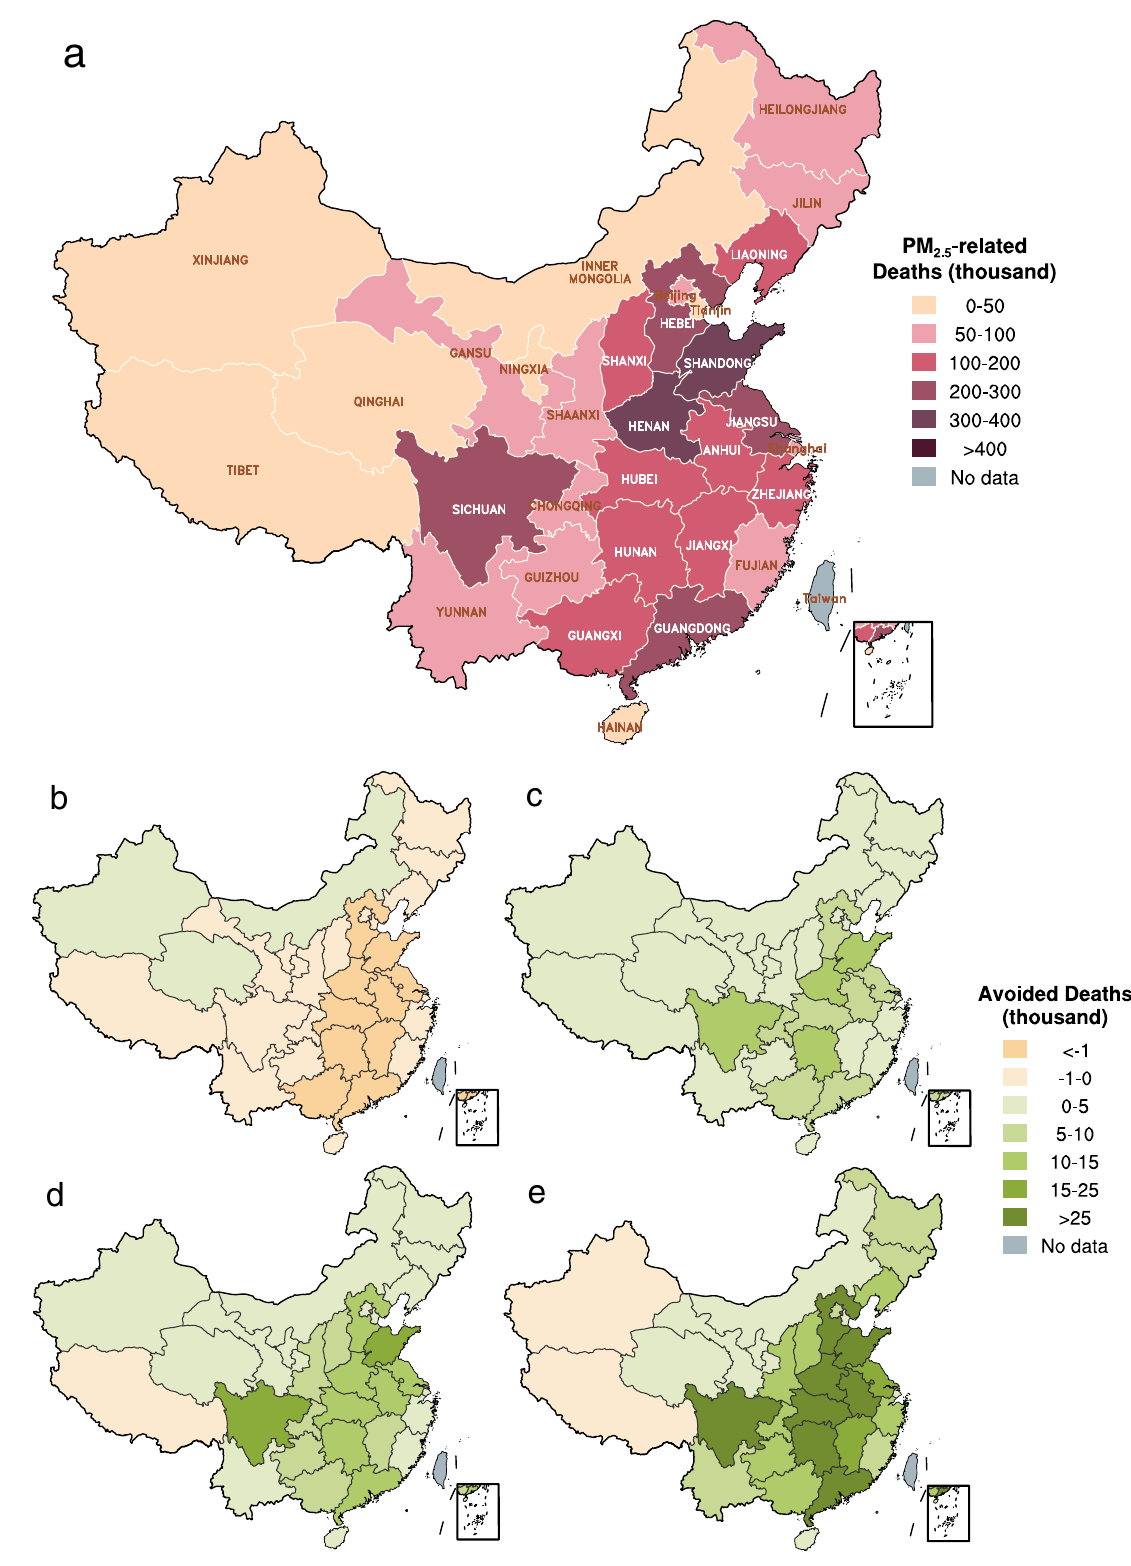
Fig. 6 China ’ s PM 2.5 -attributable mortality and that prevented by climate policies under the SSP1 pathway. a PM 2.5 -attributable mortality in the SSP1_REF scenario in 2030. b , c Difference of PM 2.5 -attributable mortality with different climate mitigation targets under the SSP1 pathway in 2030: REF- RCP2.6 and RCP2.6-RCP1.9, respectively. d , e the same as ( b , c ) but in